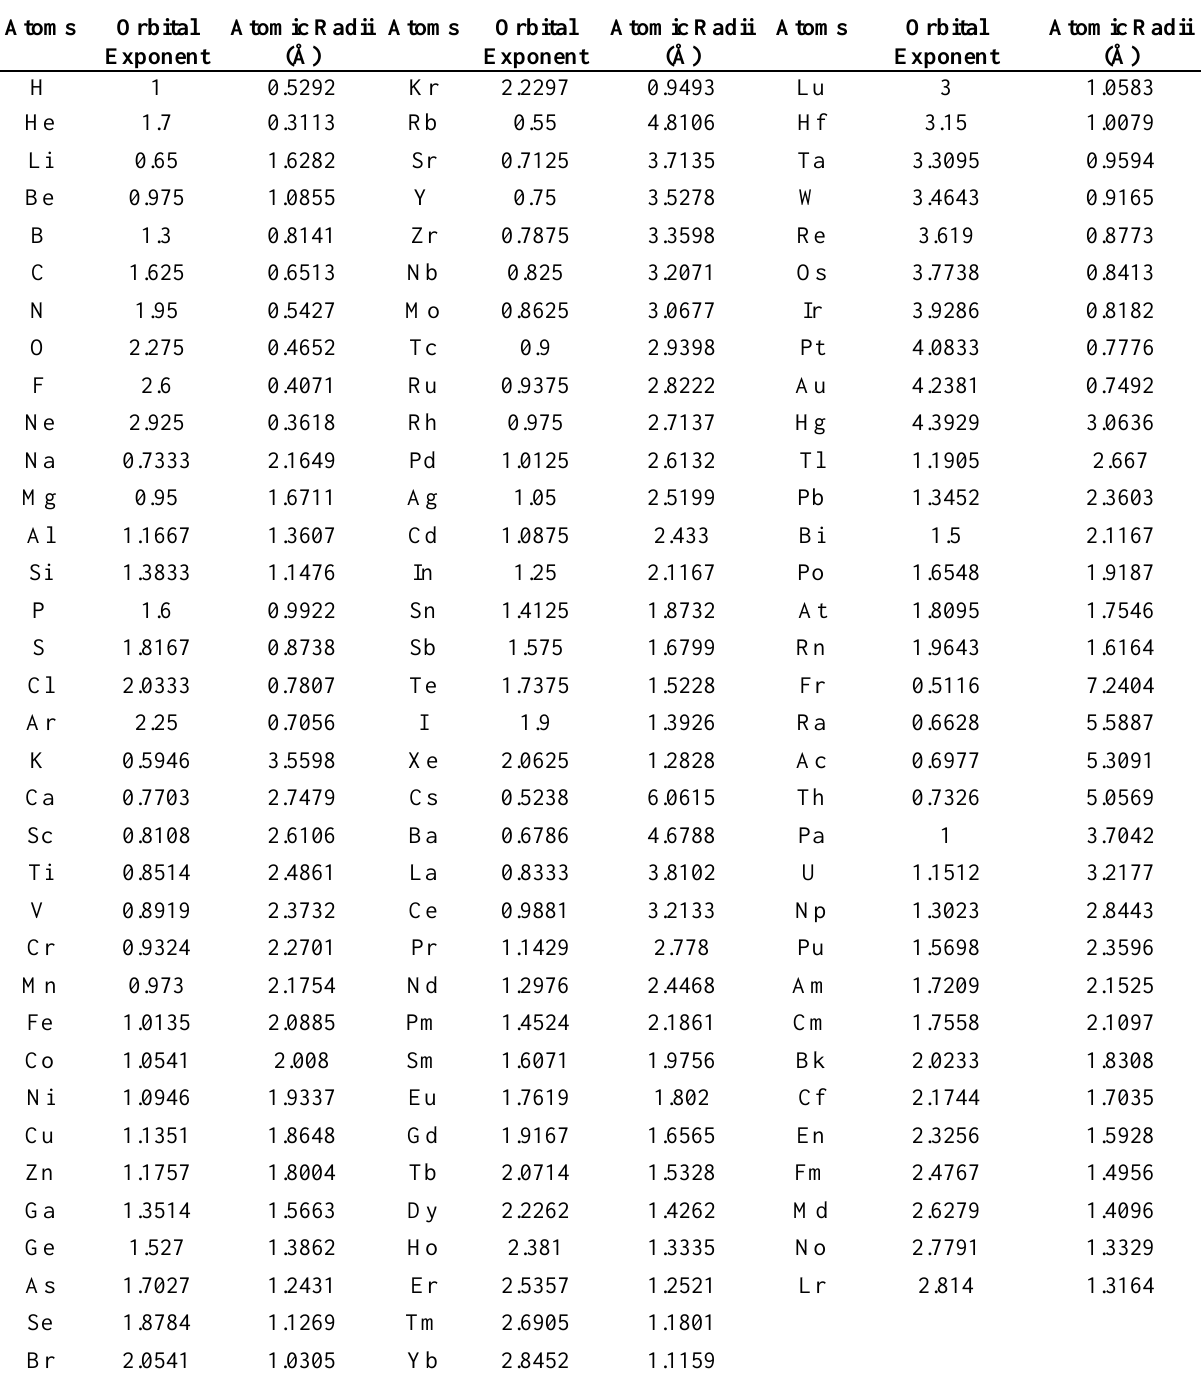
Table 1. Calculated orbital exponents ( ξ ) and radii of atoms.